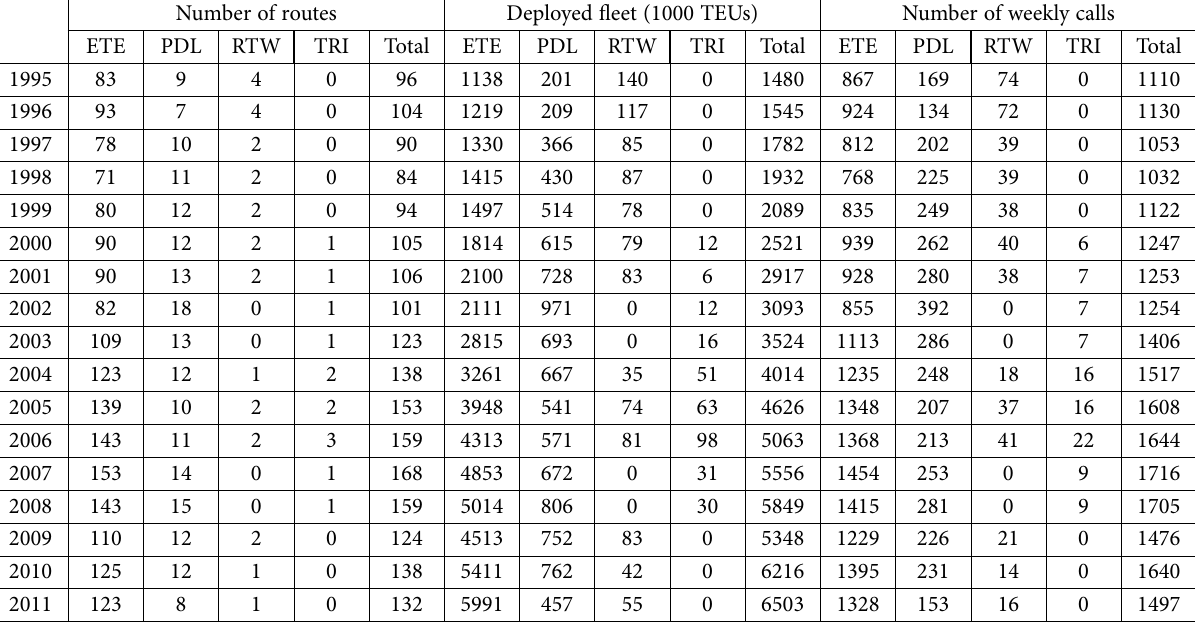
Table 2. Breakdown of routes, deployed fleet and weekly calls by operational patterns Number of